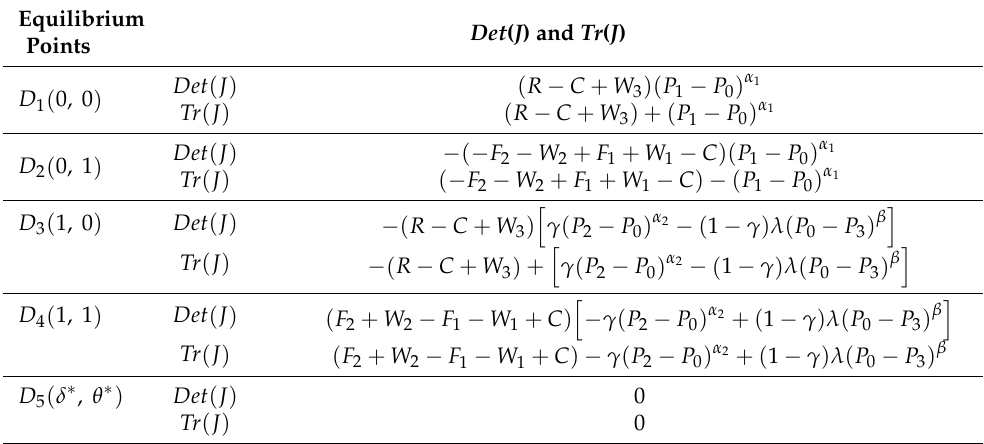
Table 2. Determinants and traces of equilibrium points. Equilibrium